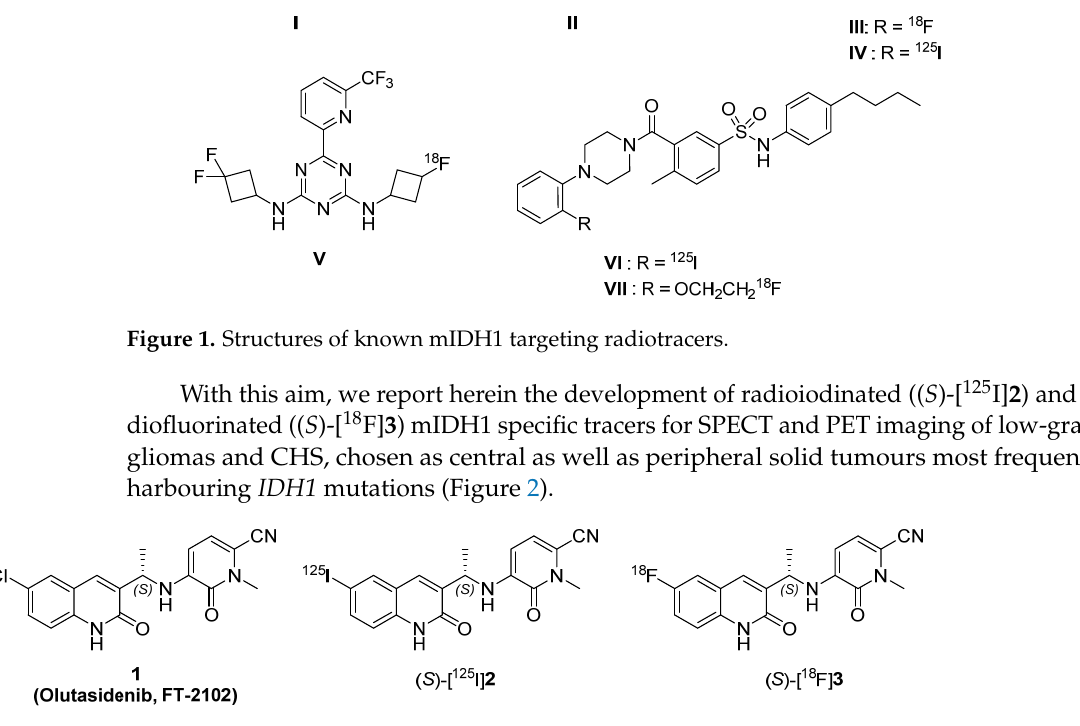
Figure 2. FT-2102 and its corresponding radioiodinated and radiofluorinated analogues.